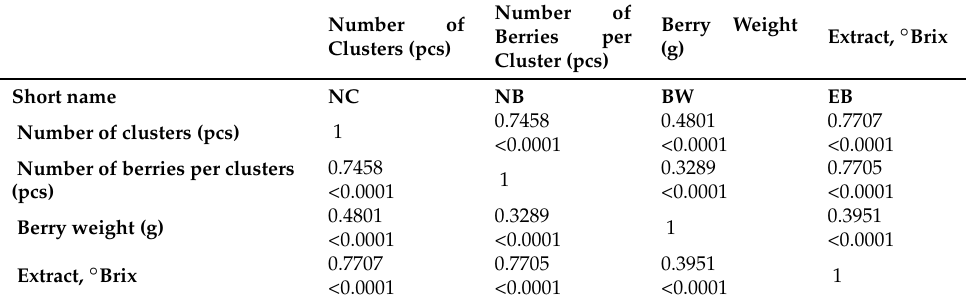
Table 5. Pearson’s analysis for optimized